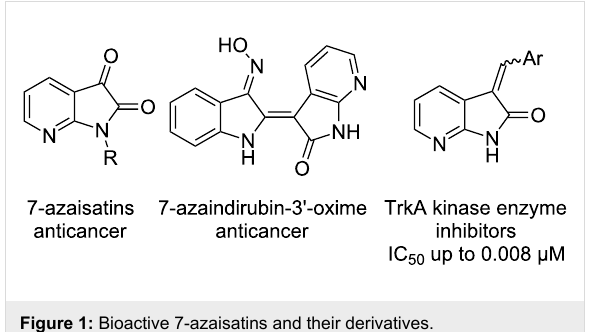
Figure 1: Bioactive 7-azaisatins and their